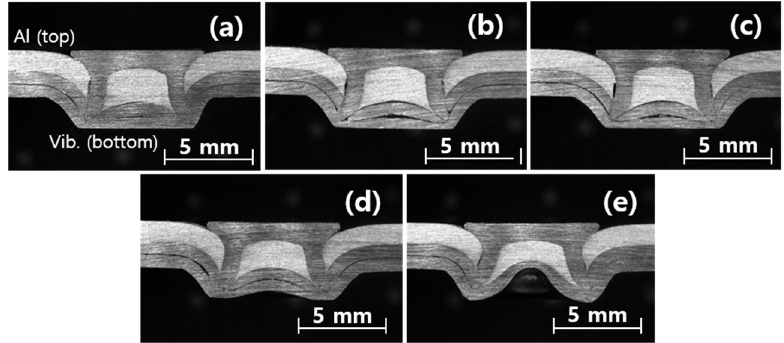
Figure 10. Cross-sectional images of SPR joints of Al5052-H32 (top) and vibration-damping steel (bottom) with respect to SPR die type. ( a ) Type A1 die, ( b ) type A2 die, ( c ) type A3 die, ( d ) type B die, and ( e ) type C die.